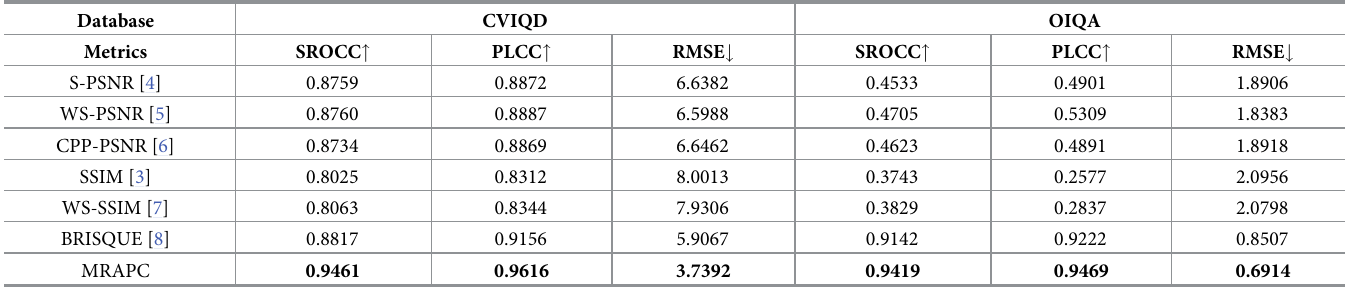
Table 2. Comparison of the overall performance of the algorithm with the proposed MRAPC and other panoramic image quality assessment algorithms.